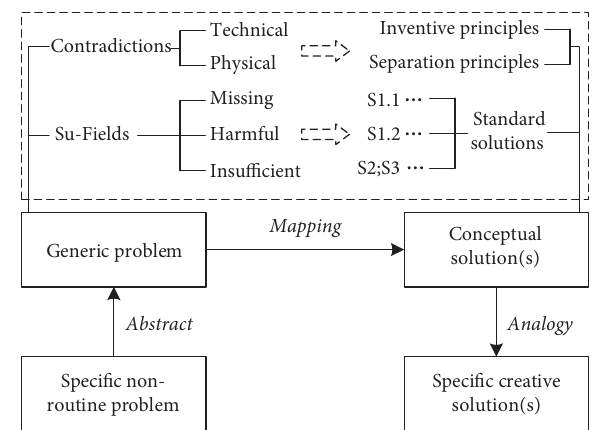
Figure 1: TRIZ problem-solving